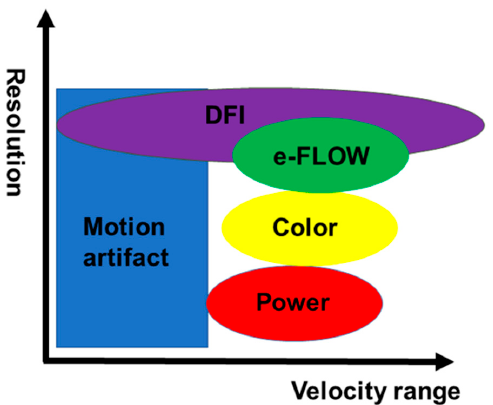
Figure 3. Comparison of DFI with conventional techniques. Conventional Doppler techniques are